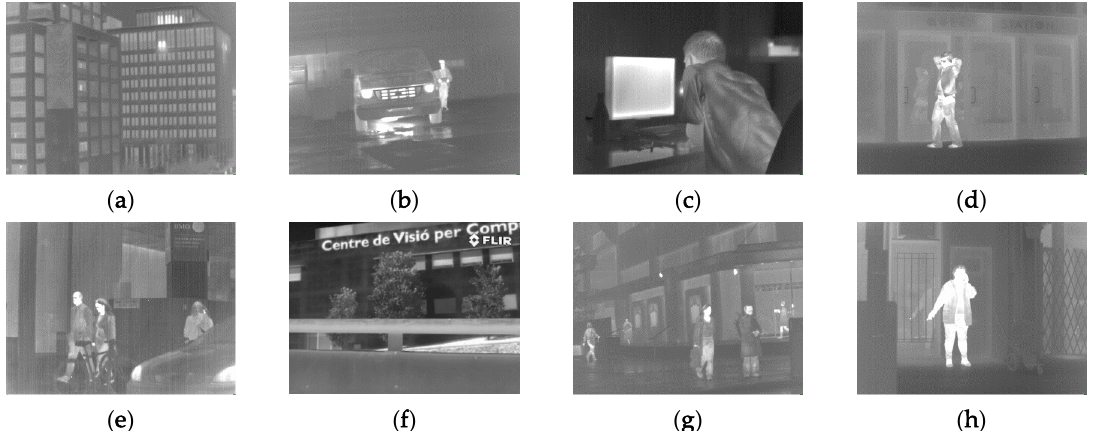
Figure 2. Test images. ( a ) Building.BMP; ( b ) Car.BMP; ( c ) Figure.BMP; ( d ) Man.BMP; ( e ) People.BMP; ( f ) Store.BMP; ( g ) Street.BMP; and ( h )